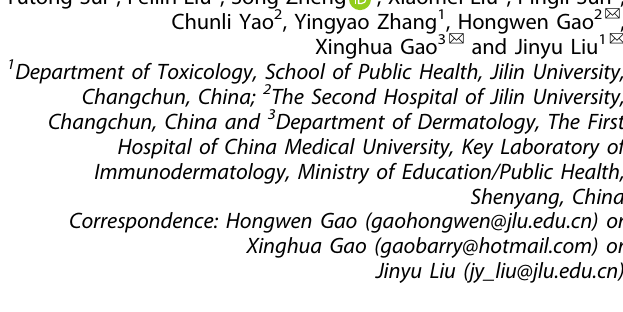
Fig. 1 PBX1 G4s formation inhibits melanoma progression by downregulating PBX1 expression. a PBX1 expression was quanti fi ed by immuno fl uorescence (IF) assays in tumor and non-tumor tissues of patients from the melanoma cohort 1. b The representative images of PBX1 IF intensity in melanoma tissues and adjacent non-cancerous tissues. Scale bar, 500 μ m. c PBX1 expression was quanti fi ed by immunohistochemistry (IHC) assays in tumor and non-tumor tissues of patients from the melanoma cohort 2. d The representative images of PBX1 IHC staining in HCC tissues and noncancerous skin tissues. Scale bar, 50 μ m. e , f The overall ( e ) and metastasis-free (Met-free) survival ( f ) analyses for patients from the melanoma cohort 2. The high (blue) and low (red) expression of PBX1 in melanoma tissues were determined by the median of PBX1 expression levels in all melanoma samples or the melanoma samples without metastasis. Survival curves were calculated using Kaplan – Meier method, and the signi fi cance was determined by log-rank test. g , h CD spectrum of WT and Mut dG1 ( g ). CD spectrum of WT and Mut rG1 ( h ). CD, circular dichroism. i The activity of G-quadruplex in HEK293T, A375 and B16-F10 cells were performed by luciferase reporter assays. j HEK293T, A375 and B16-F10 cells were treated with or without 2 μ M PDS or 5 μ M TMPyP4 for 48 h. Left: representative confocal images. Scale bars: 100 μ m. Right: the relative fl uorescent value was measured. k – n The mRNA and protein levels of PBX1 in A375 cells were detected by qRT-PCR and western blot. PDS (2 μ M) or TMPyP4 (5 μ M) treatment for 48 h inhibits the PBX1 mRNA ( k , m ) and protein levels ( l , n . From left to right: PBX1 protein level, statistical analysis of western blot results. PBX1 protein levels were normalized to the GAPDH protein levels.). o The protein levels of PBX1 in A375 with ASO Scr or ASO rG1 (25 nM) treatment for 48 h. p PBX1-wild type (WT) or PBX1-knockout (KO) A375 cells-derived xenograft tumor volume measurements at day 0, 4, 8, 12, 14, 21, 28 and 35. q Melanoma patient-derived xenograft (PDX) tumor volume measurements at day 0, 7, 14 and 21. ( n = 7 mice/group). r Melanoma PDX tumor weight of mice neoplasm after mice sacri fi ce. s Relative expression levels of ZIC2 and PBX1 expressing si-scramble or si-ZIC2, detected by western blot. t The occupancy of ZIC2 in the promoter region of PBX1 was measured by ZIC2 ChIP in A375 cells with or without PDS and TMPyP4 treatment, followed by qRT-PCR. u The schematic of targeting PBX1 G-quadruplexes for melanoma therapy (Figure was modi fi ed from Servier Medical Art (http://smart.servier.com/), licensed under a Creative Common Attribution 3.0 Generic License. (https://creativecommons.org/licenses/by/3.0/)). Data are shown